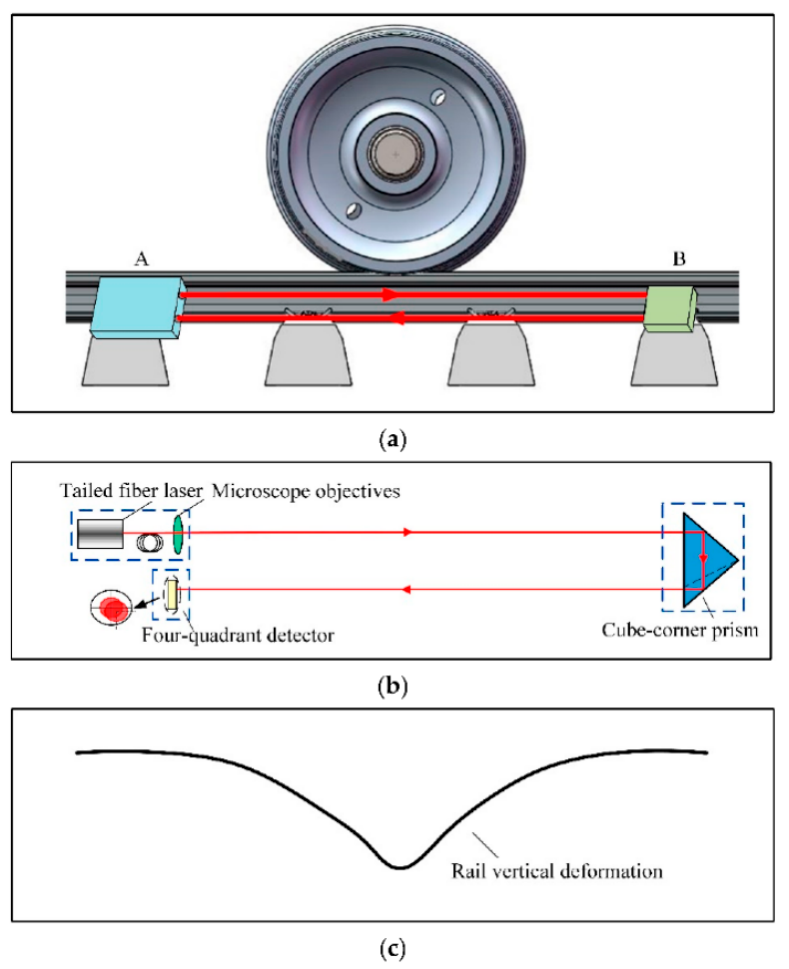
Figure 7. The schematic diagram of the sensor and the rail vertical deformation: ( a ) The installation location of the sensor; ( b ) The schematic diagram of the sensor; ( c ) The rail vertical deformation [78]. A vibration signal-based flat detection system was developed by Jyoti Barman and Durlav Hazarika [79]. In this system, the vibration signal was captured by an ADXL335 vibration sensor connected to the fish-plate of the track and linear time-frequency transform (wavelet transform) combined with a quadratic time-frequency transform (Wigner-Ville transform) were used to find the flat